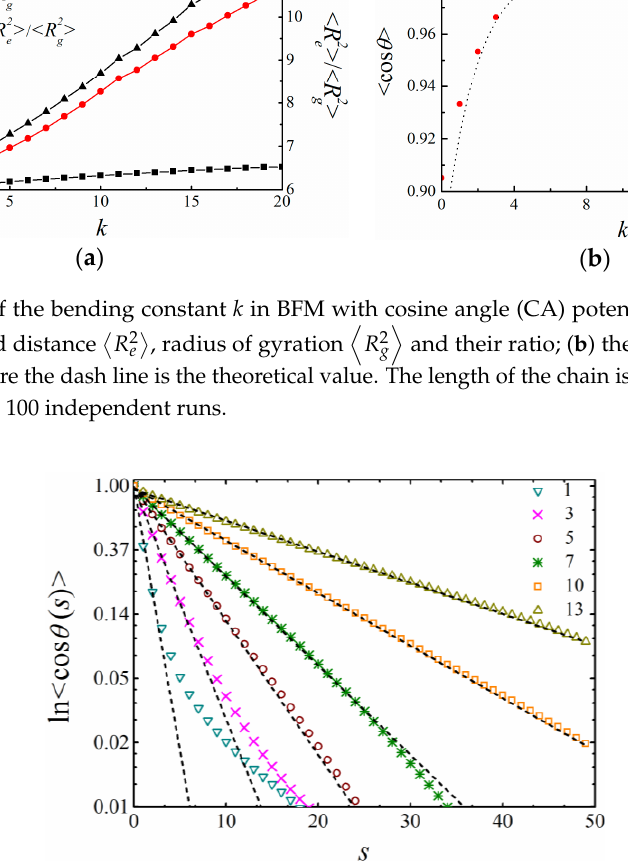
Figure 3. The orientation correlation function as a function of the chemical distance s along the chain with an indicated bending constant k . The dashed lines indicate the fits of the initial decay. In simulations, it is important to ensure that persistent length is not affected by chain length. We further examined polymers with 𝑁 = 20 and 70, respectively (Figure 5). At low chain stiffness ( k < 10), persistent length was not affected by chain length, which is consistent with the conclusion made by Cifra [9]. At high chain stiffness, the result was affected by both the chain length and the calculation methods. The calculation of l p,ee was suitable for all chain models [9], but l p,ee was even